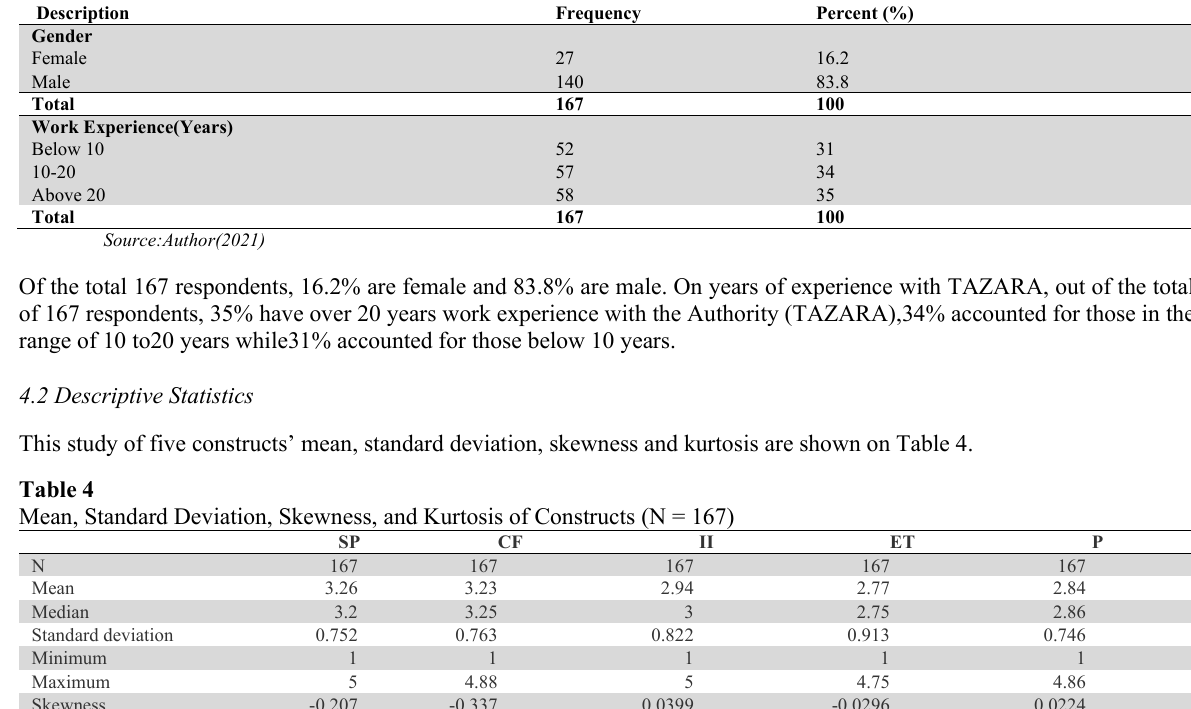
Demographic Profile